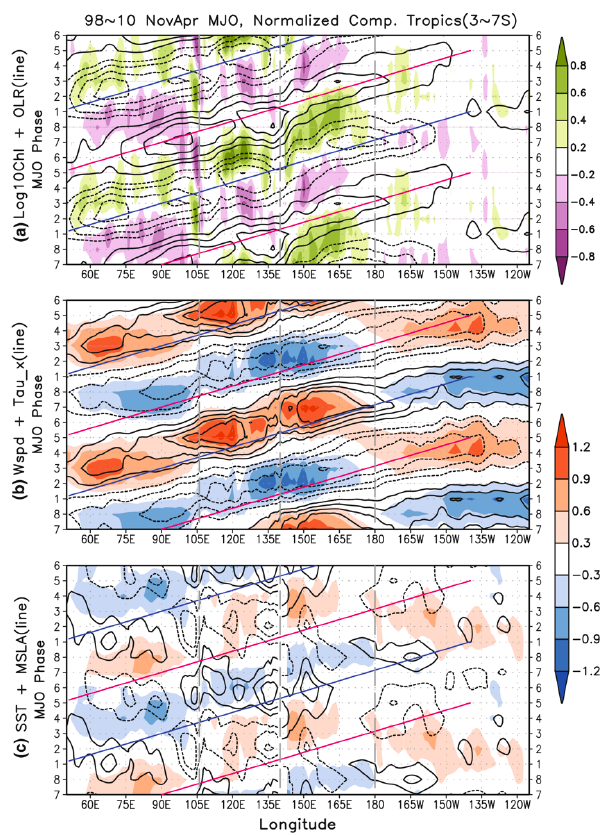
Figure 8. MJO composite evolution for the boreal winter (November–April) averaged over latitudes 3–7 ◦ S for the period of 1 November 1997 to 31 October 2010: (a) Log 10 Chl from Sea- WIFS satellite observations (shaded) and satellite-derived outgo- ing longwave radiation (contour); (b) wind speed (shaded) and zonal wind stress (contour), both from the cross-calibrated multi- platform (CCMP) data set; and (c) NOAA-OI satellite SST anoma- lies (shaded) and AVISO mean sea level anomaly (contour). All contour intervals match shading levels in (c) , and a solid (dashed) line indicates positive (negative) values. All variables are normal- ized, and the same MJO composite is repeated for two cycles for convenience. There are between 127 and 227 events in the compos- ite for each MJO phase. Diagonal red lines indicate peak signals of positive OLR, and blue lines indicate negative OLR peak; these are guides for the MJO propagation. The relative location of each propagation line in all panels is the same. The left and centre dashed vertical grey lines indicate the western and eastern boundary of the Maritime Continent, respectively, and the right grey line is on the In- ternational Date Line where chlorophyll a propagation stops. From Jin et al.